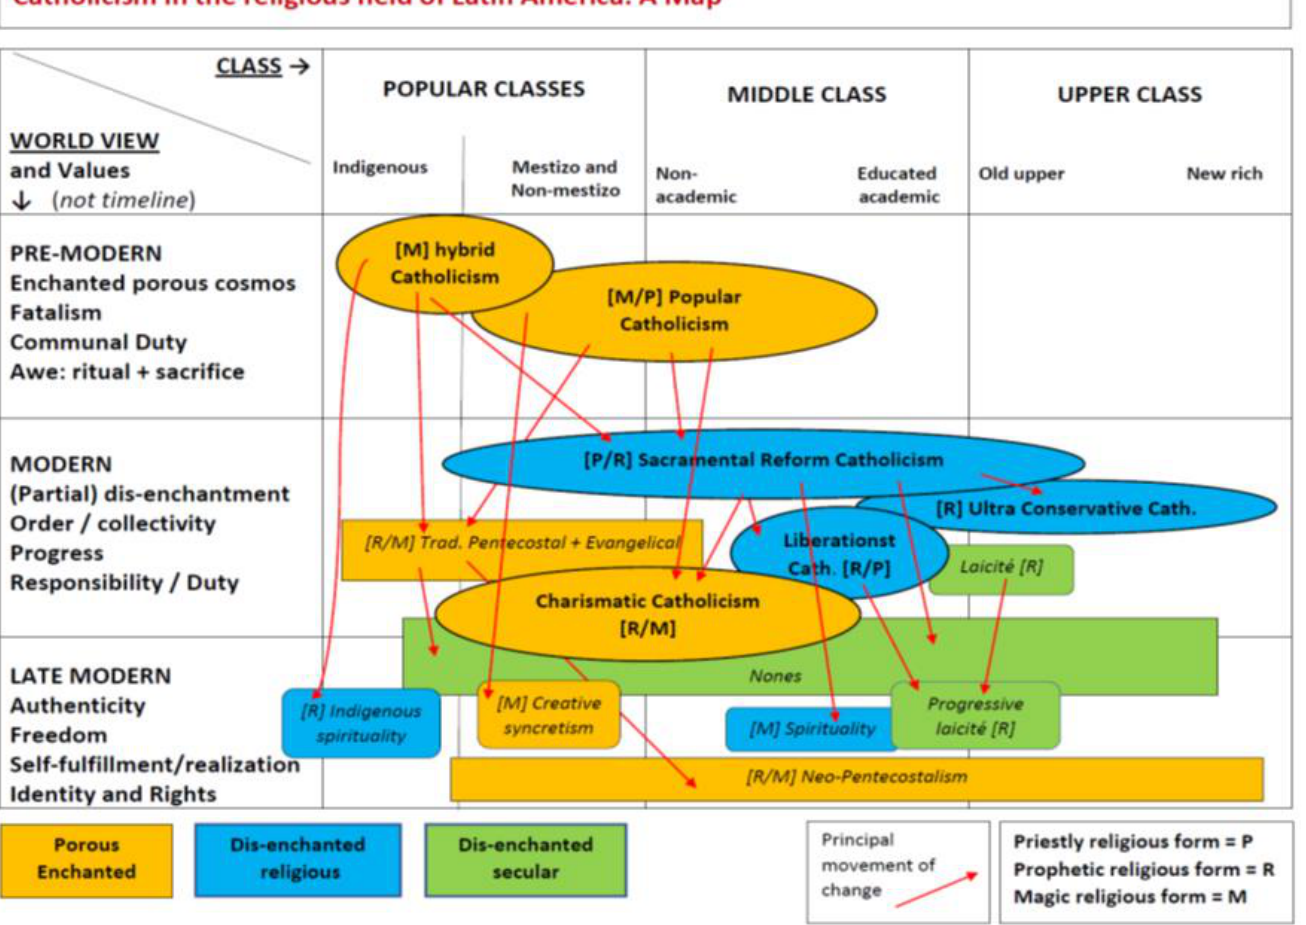
The left column indicates the different worldviews (and their characteristics and val- ues) that coexist in Latin America, and which are here labelled as either pre-modern, mod- ern, or late modern. The upper row indicates the different social classes found in